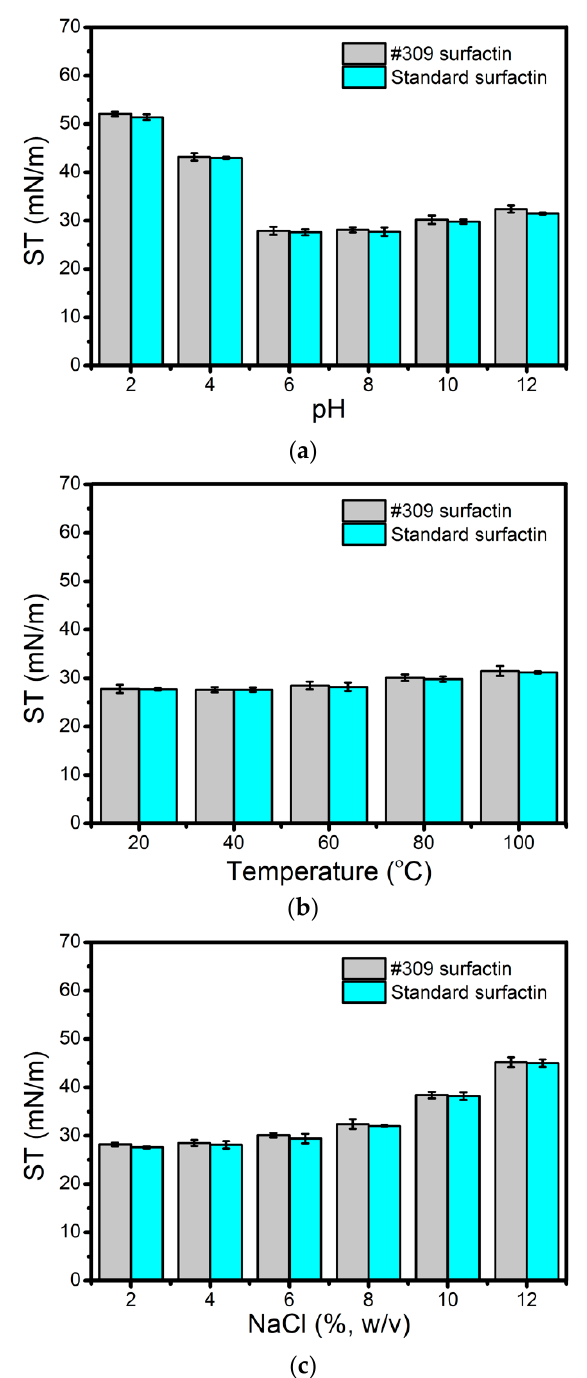
Figure 4. Stability studies using the biosurfactant produced by Bacillus subtilis #309 when grown in mineral salt medium (MSM) supplemented with soap-derived crude glycerol and surfactin standard (Merck, Darmstadt, Germany), under different pH values ( a ), temperatures ( b ) and salinities ( c ). Measurements were performed at room temperature (25 °C) after incubation at different pHs, temperatures and salinities for 2 h. The reference surface tension value was 70.4 mN/m. The results represent the mean ± standard deviation of three independent experiments performed in triplicate.